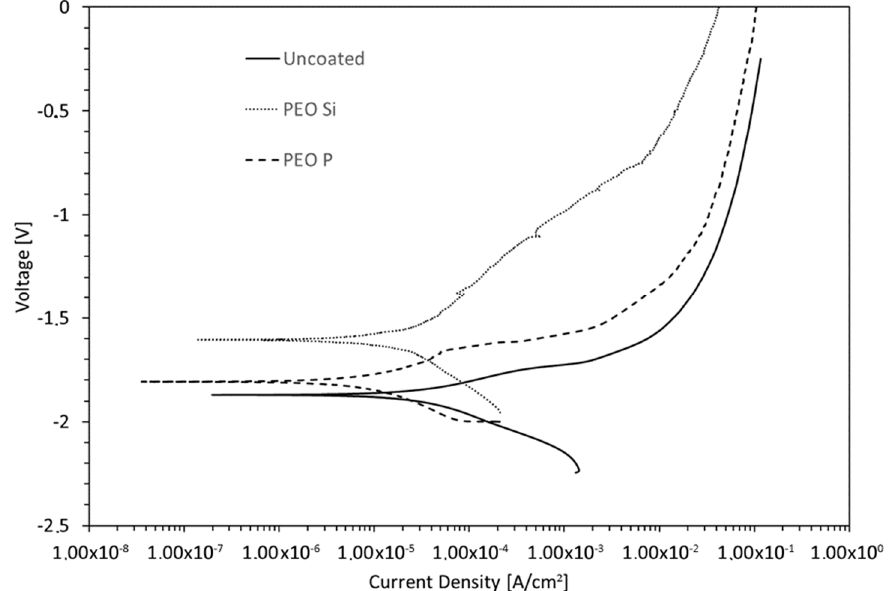
Figure 4. Potentiodynamic polarization curves of the samples PEO-Si and PEO-P (test electrolyte: 0.1 M Na 2 SO 4 and 0.05 M NaCl). Table 3. Corrosion potentials and corrosion current density extrapolated from the potentiodynamic polarization plot.